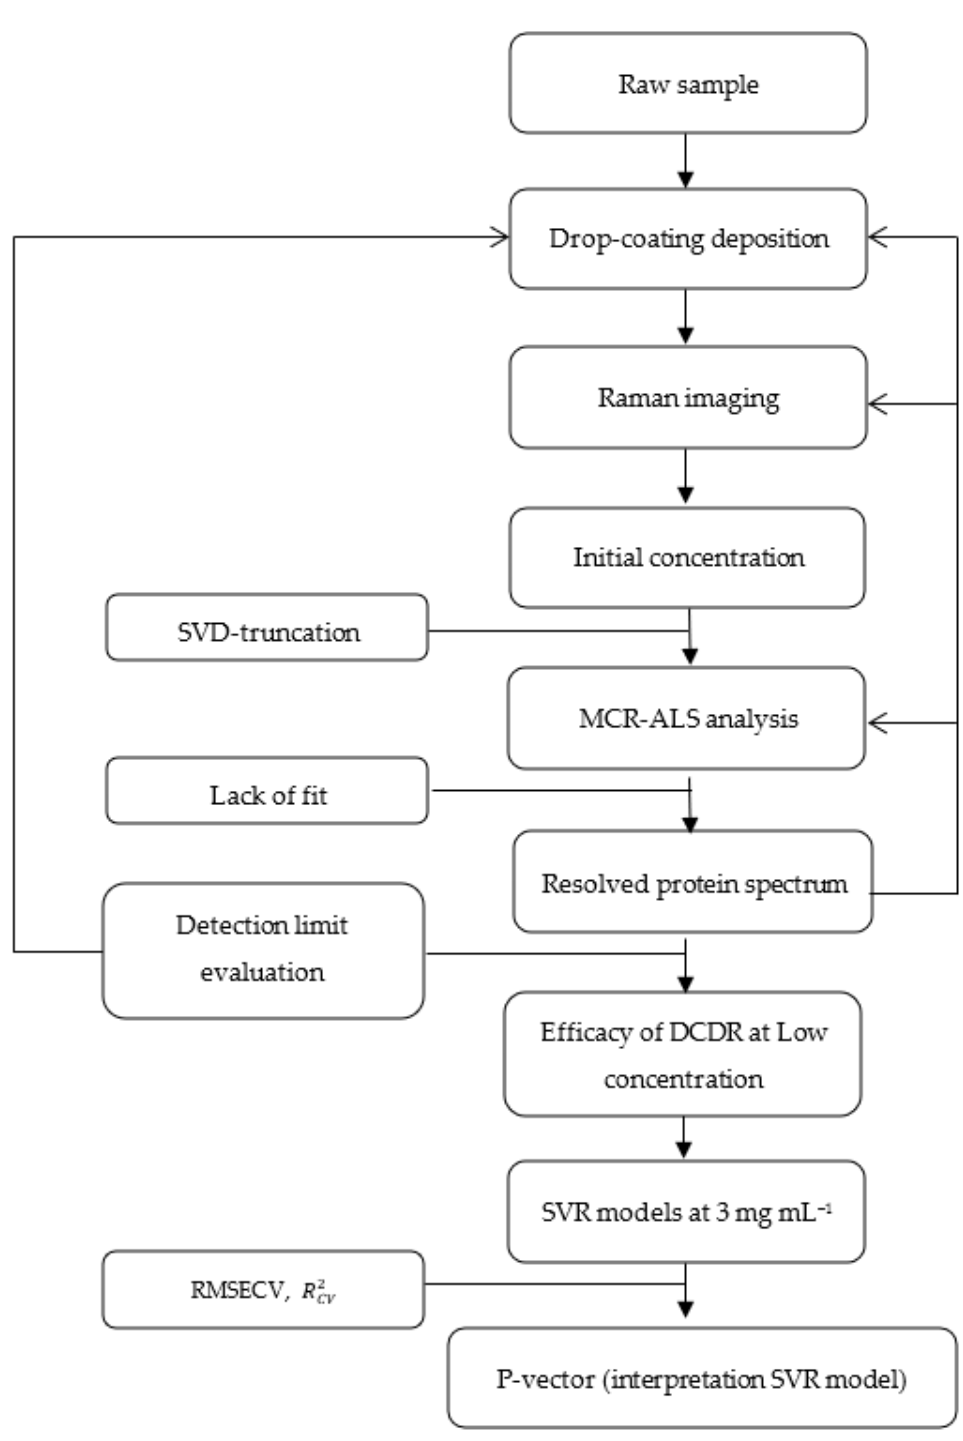
Figure 2. Schematic description of the general methodology followed in the study for the analysis of mAbs by drop-coating deposition Raman combined with MCR-ALS analysis and SVR.